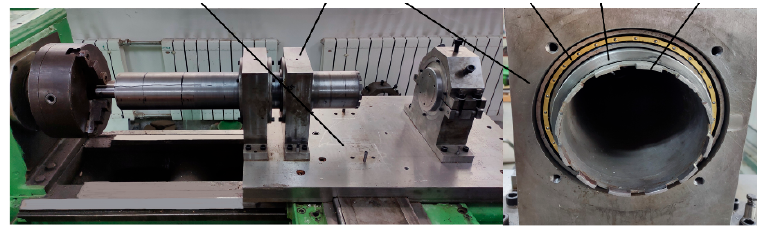
Figure 2. Tool holder system. Figure 3. Equivalent model of the machining system.